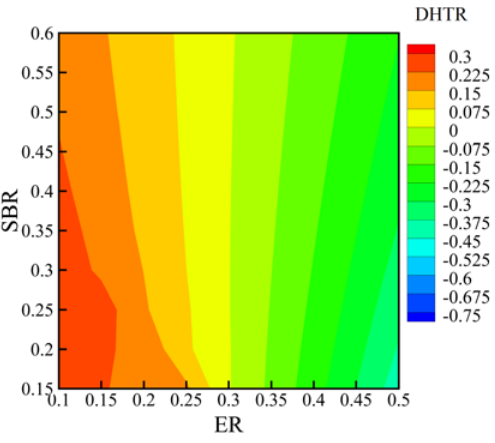
Figure 22. DHTR distribution at T = 1100 K.